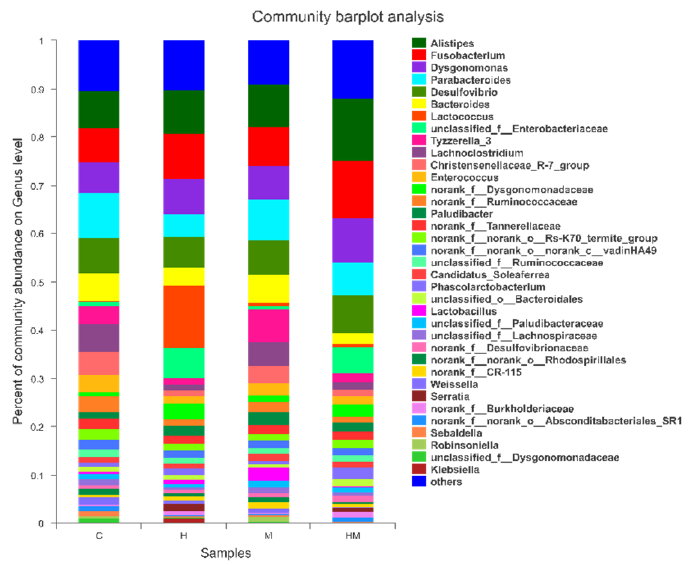
Figure 3. Bacterial composition of the di ff erent communities at the phylum level. H, hydramethylnon sample; M, M. anisopliae sample; HM, hydramethylnon and M. anisopliae sample; C, control sample.